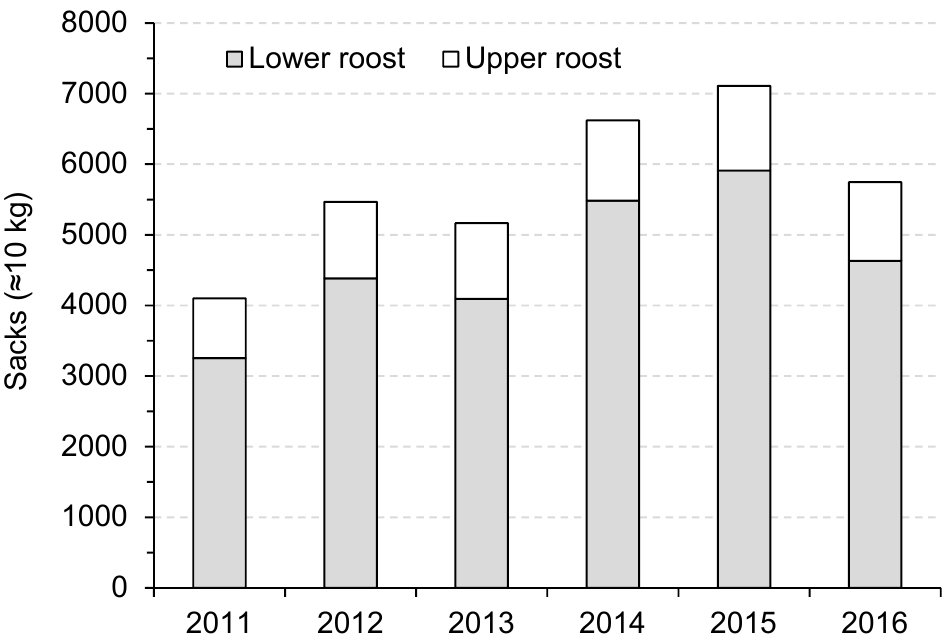
Figure 5. Annual guano harvest from Ta Rumm #1 cave (Battambang province, north-western Cambodia), 2011–2016.